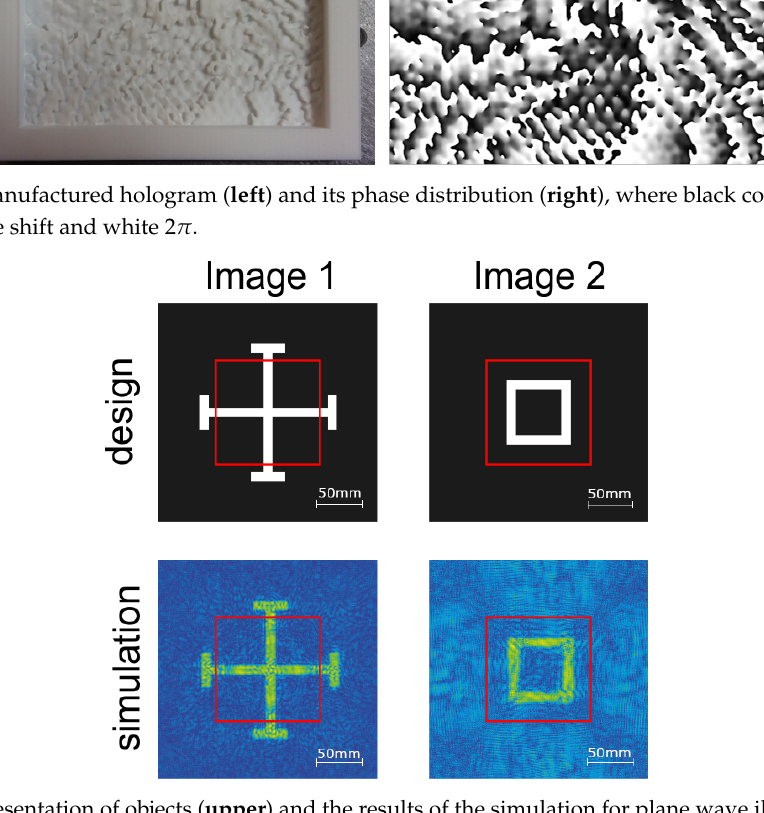
Figure 5. Presentation of objects ( upper ) and the results of the simulation for plane wave illumination ( lower ) for both image planes. Red squares denote the size of the